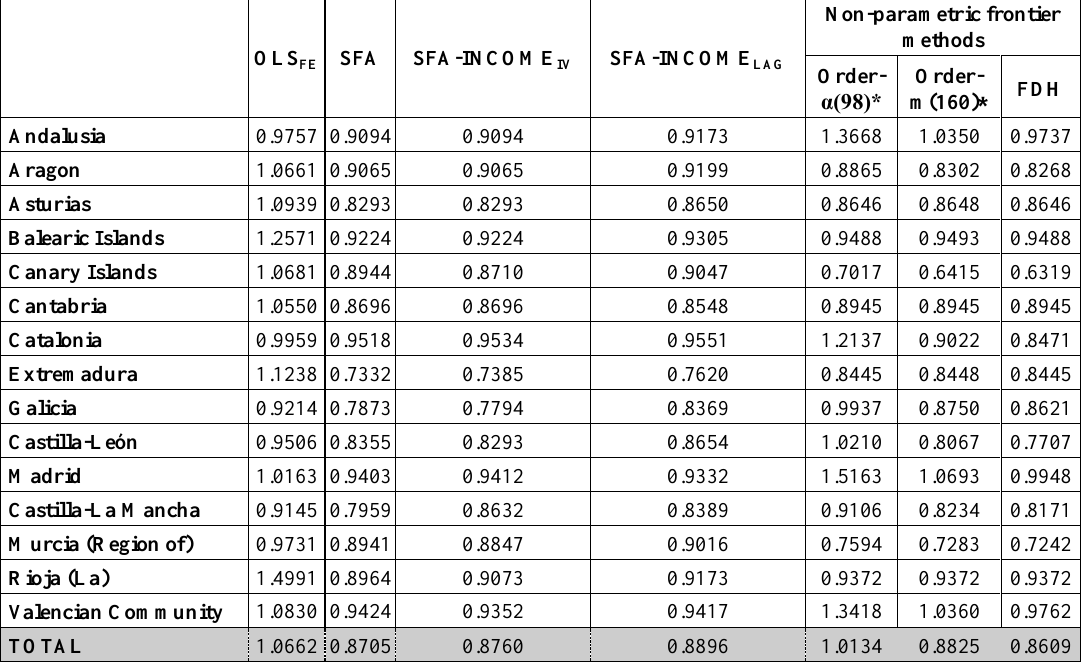
Table 5 : Use of tax revenue capacity in Spanish